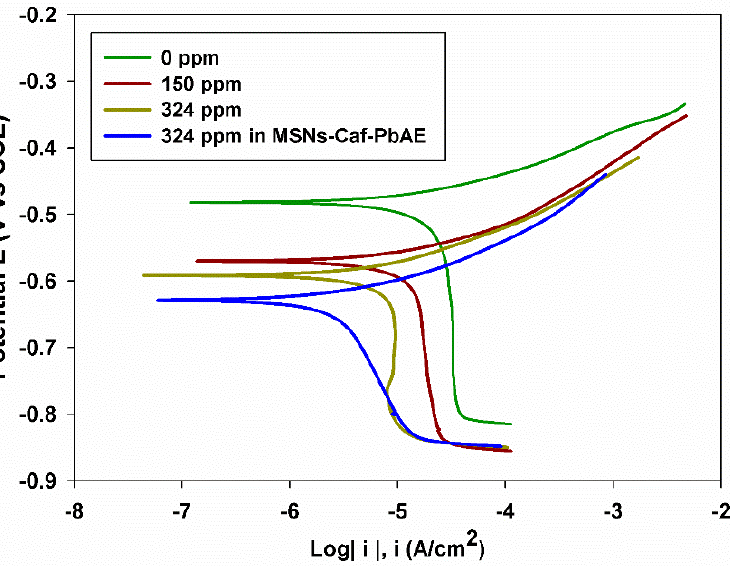
Figure 6. Polarization curves from the potentiodynamic polarization of the API X60 carbon steel in 3.5% NaCl solution with pH = 5, with direct addition of 0, 150, and 324 ppm of free caffeine compared with a solution containing 324 ppm of caffeine encapsulated into MSNs-Caf-PbAE (0.2% MSNs w / v ) at 27 °C.